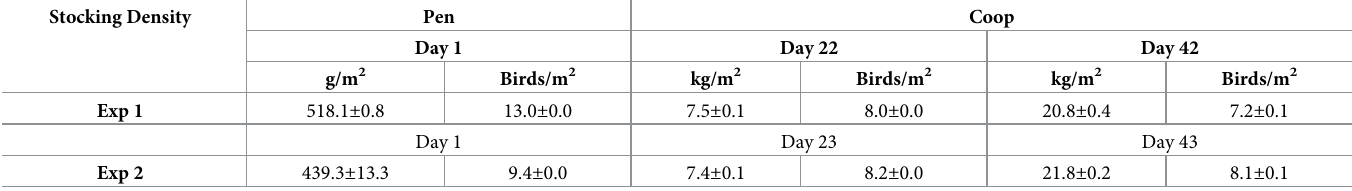
Table 1. Mean ( ± SEM) of pen and coop stocking density on day 1, day 22–23, and day 42–43 of age in Experiments 1 (Exp 1) and 2 (Exp 2). Stocking